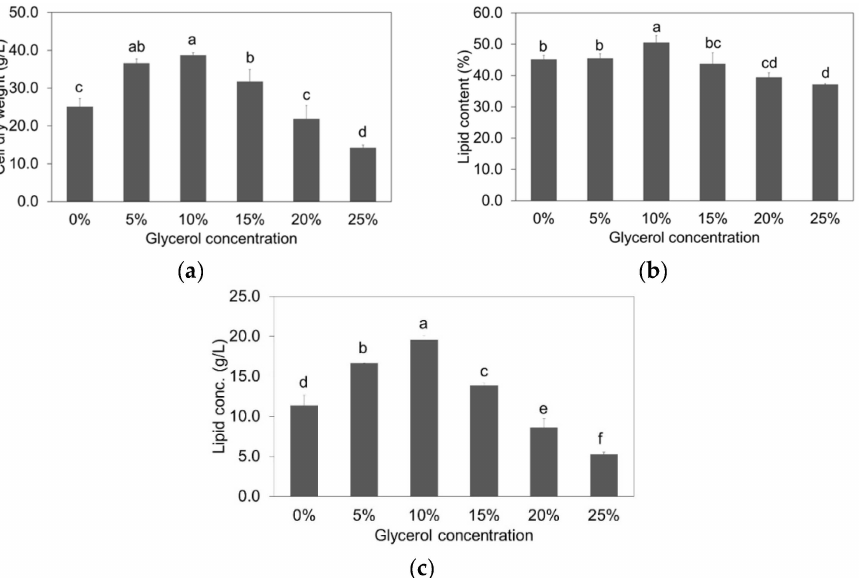
Figure 6. Cell dry weight ( a ), lipid content ( b ) and lipid concentration ( c ) when culturing of R. glutinis TISTR 5159 in hydrolysate at a C/N molar ratio of 27 while varying the carbon concentration using glycerol at 30 ◦ C with orbital shaking at 200 rpm. Different letters above the bars indicated significant differences in mean values at 95% confidence